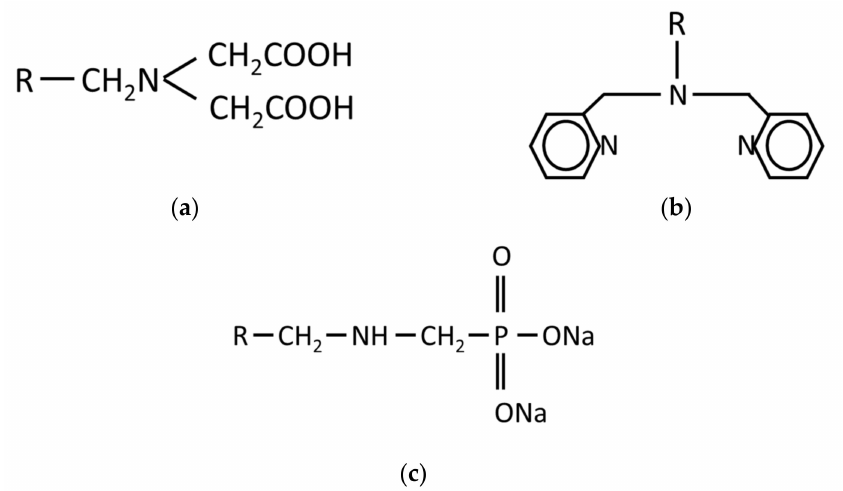
Figure 3. Functional groups of chelating resins reported in the literature for Co recovery: ( a ) iminodi- acetate; ( b ) bis-pycolilamine; and ( c ) aminophosphonate acid